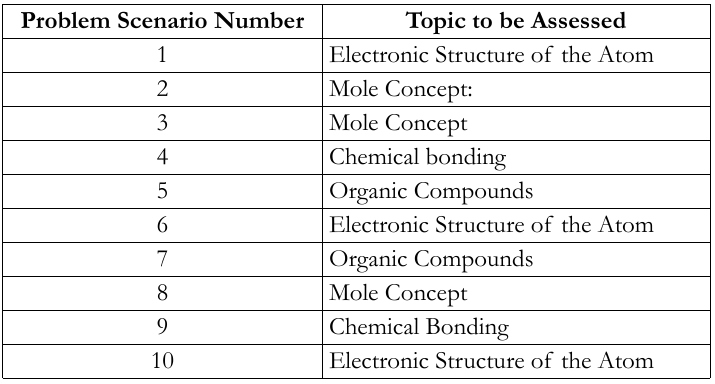
Table 2. The topics included in the problem scenarios used in